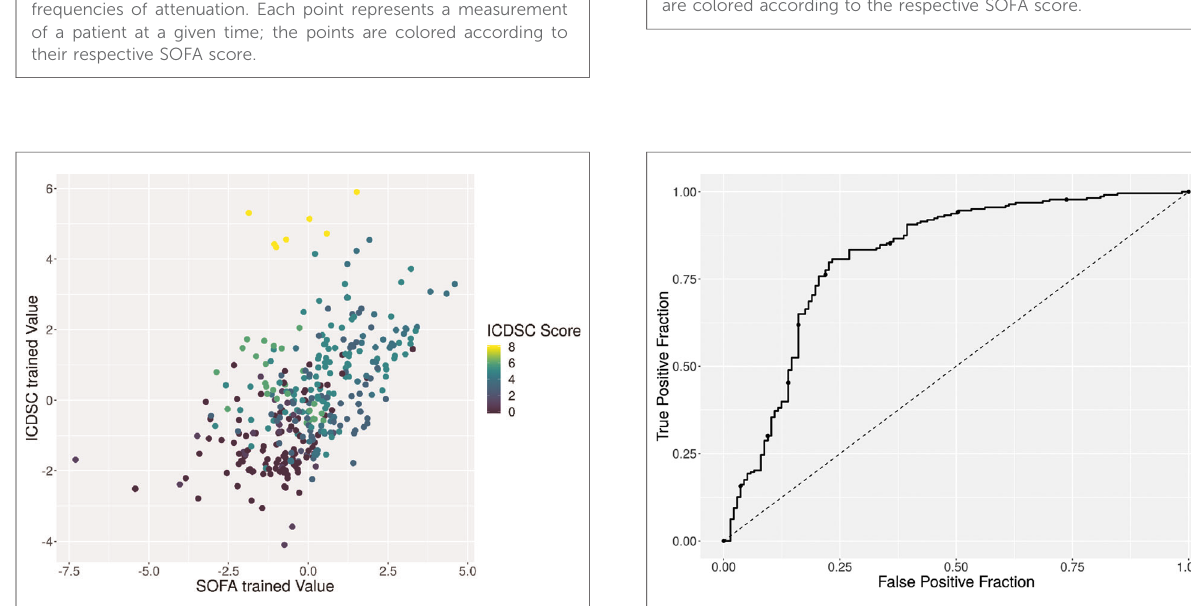
FIGURE 10 Scatterplot of the trained principal components. Each point represents a measurement of a patient at a given time; the points are colored according to the respective ICDSC score.